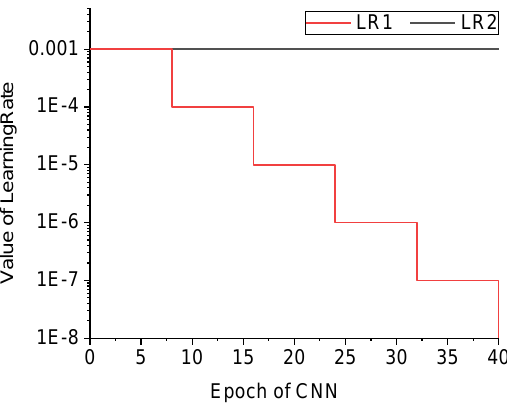
Figure 7. Two learning rate curves during the network training period. Table 2. Specific structure of the CPD network (where h , w , and d are height, width, and depth, respectively; Conv is convolution layer; MX is MaxPooling layer; FC is fully connected layer; D is dropout layer; S is softmax layer; NOI is number of input; NOO is number of